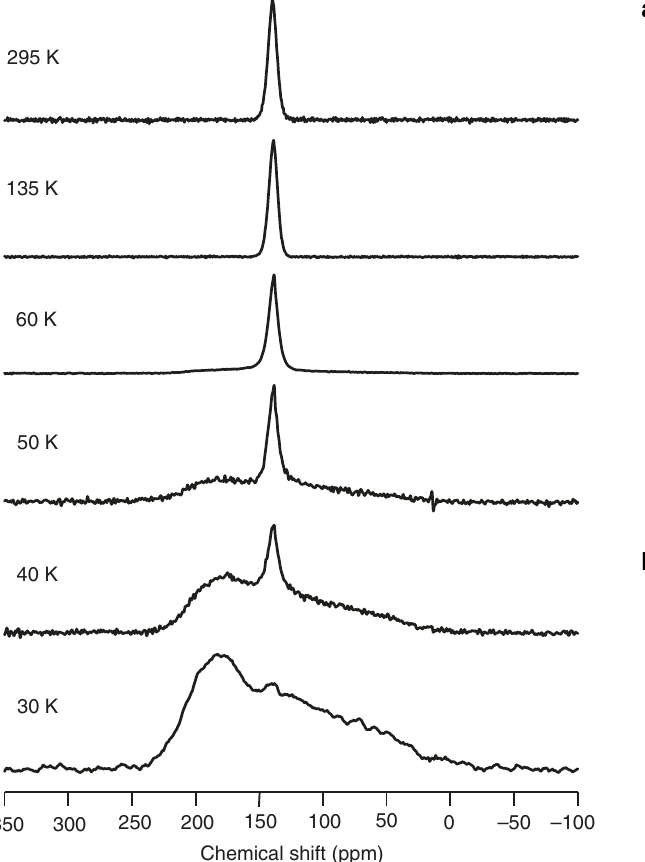
Fig. 2 Variable-temperature solid-state NMR analysis of ( P )-(12,8)-[4] CC ⊃ C 60 . Measurements were performed under static conditions (9.39 T) without MAS. Fullerene C 60 was enriched with 13 C (20 – 30%)